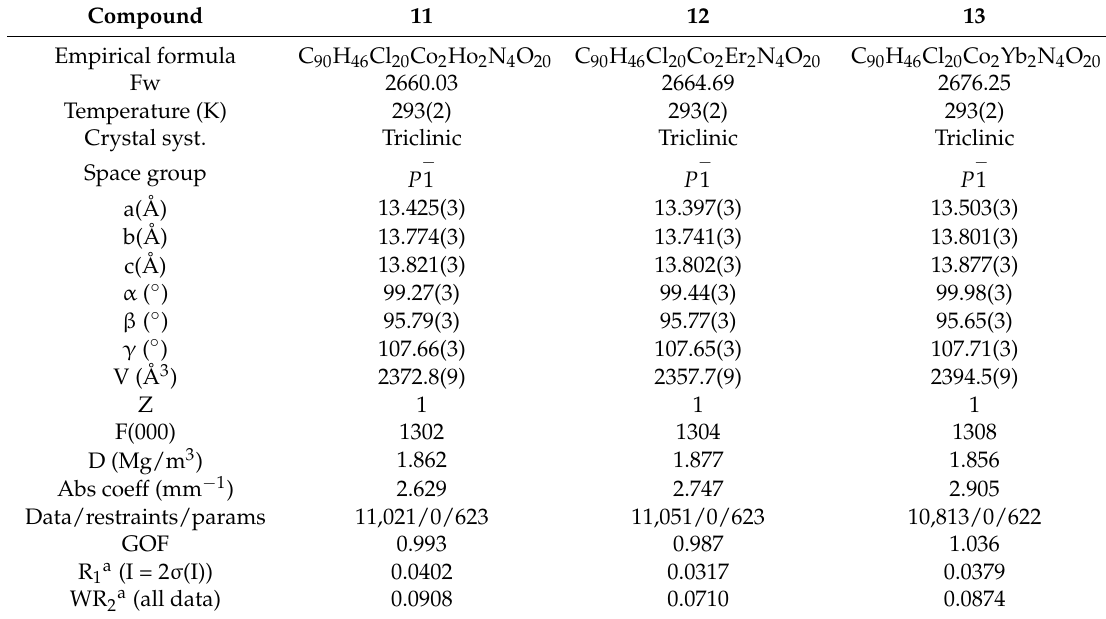
Table 4. Crystal data and structure refinement information for 11 – 13.